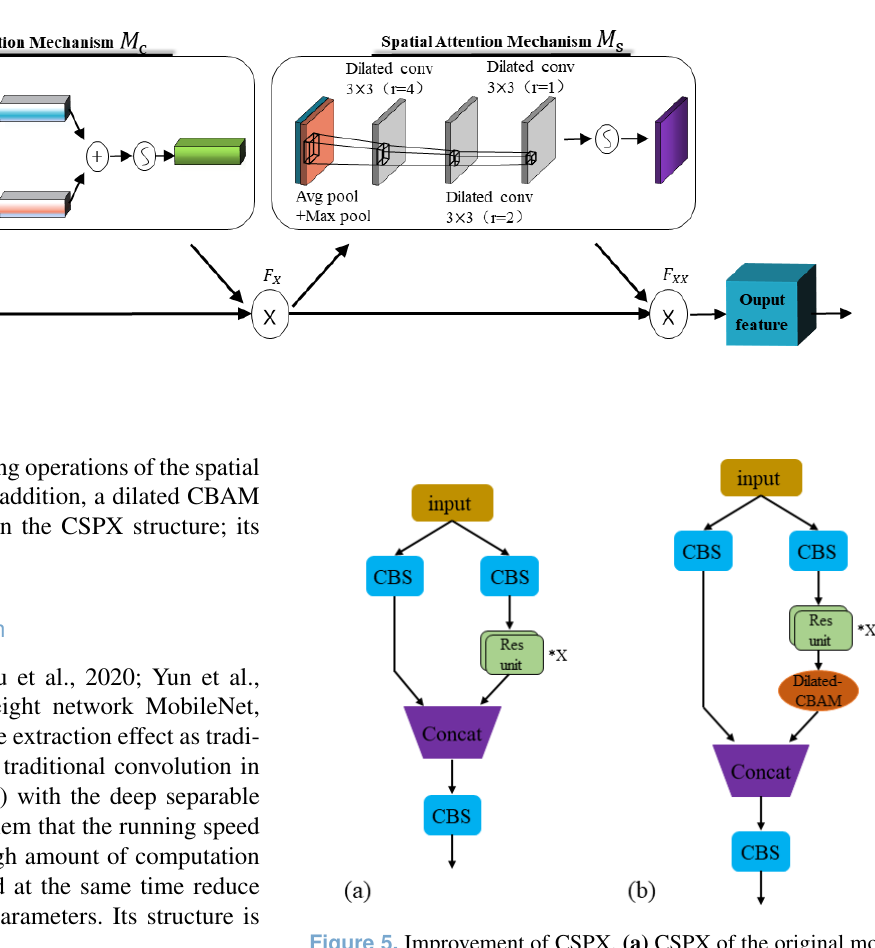
Figure 3. Improved YOLOX network structure.